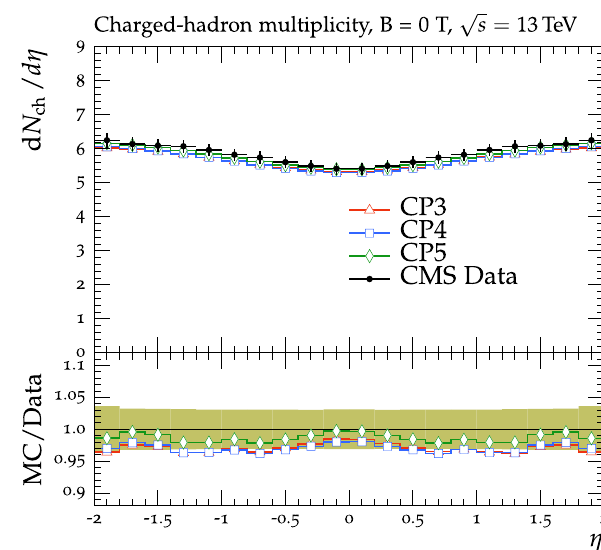
Fig. 10 The pseudorapidity distribution of charged hadrons measured in | η | < 2foraninclusiveselectionininelasticproton-protoncollisions, withzeromagneticfieldstrength(B=0T),fromtheCMS analysis [18]. The data are compared with the CMS pythia 8 LO-PDF tunes CP1 and CP2 (left), and with the CMS pythia 8 NLO-PDF tune CP3 and the CMS pythia 8 NNLO-PDF tunes CP4 and CP5 (right).